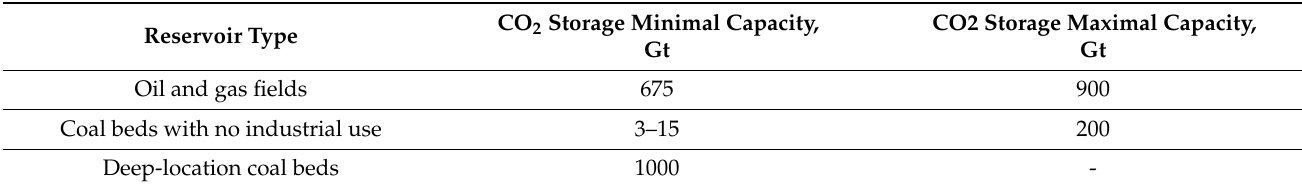
Table 1. Geological storage options for CO 2